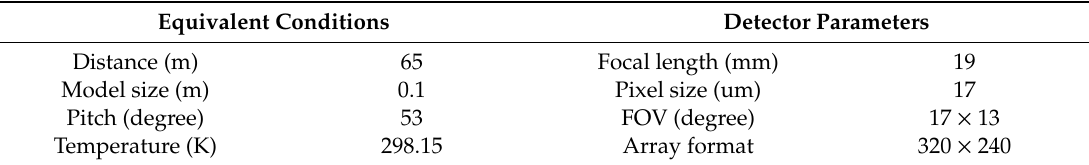
Table 1. Equivalent conditions and the parameters of the